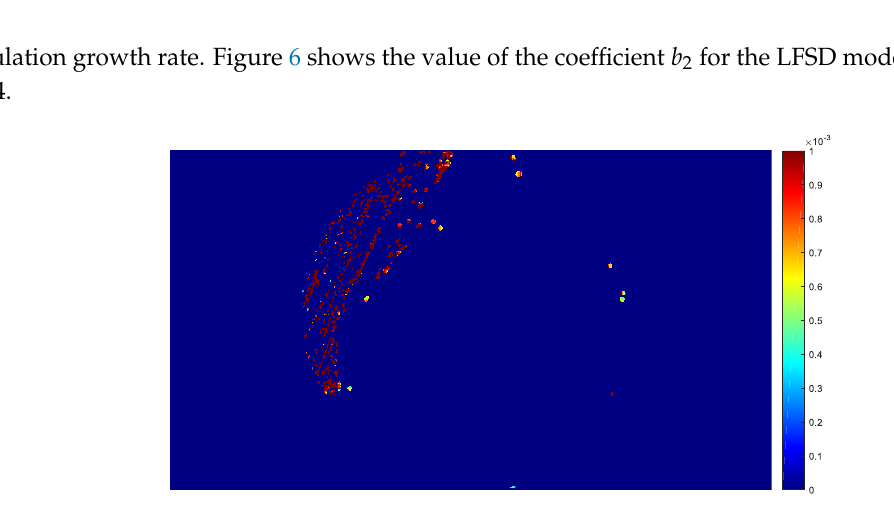
Figure 6. The parametric image resulting from the determination of the linear exponent b 2 of the LF with second degree (LFSD), for each non-zero pixel of the image in the final frame, using the region of interest (ROI) with r = 4 pixels.